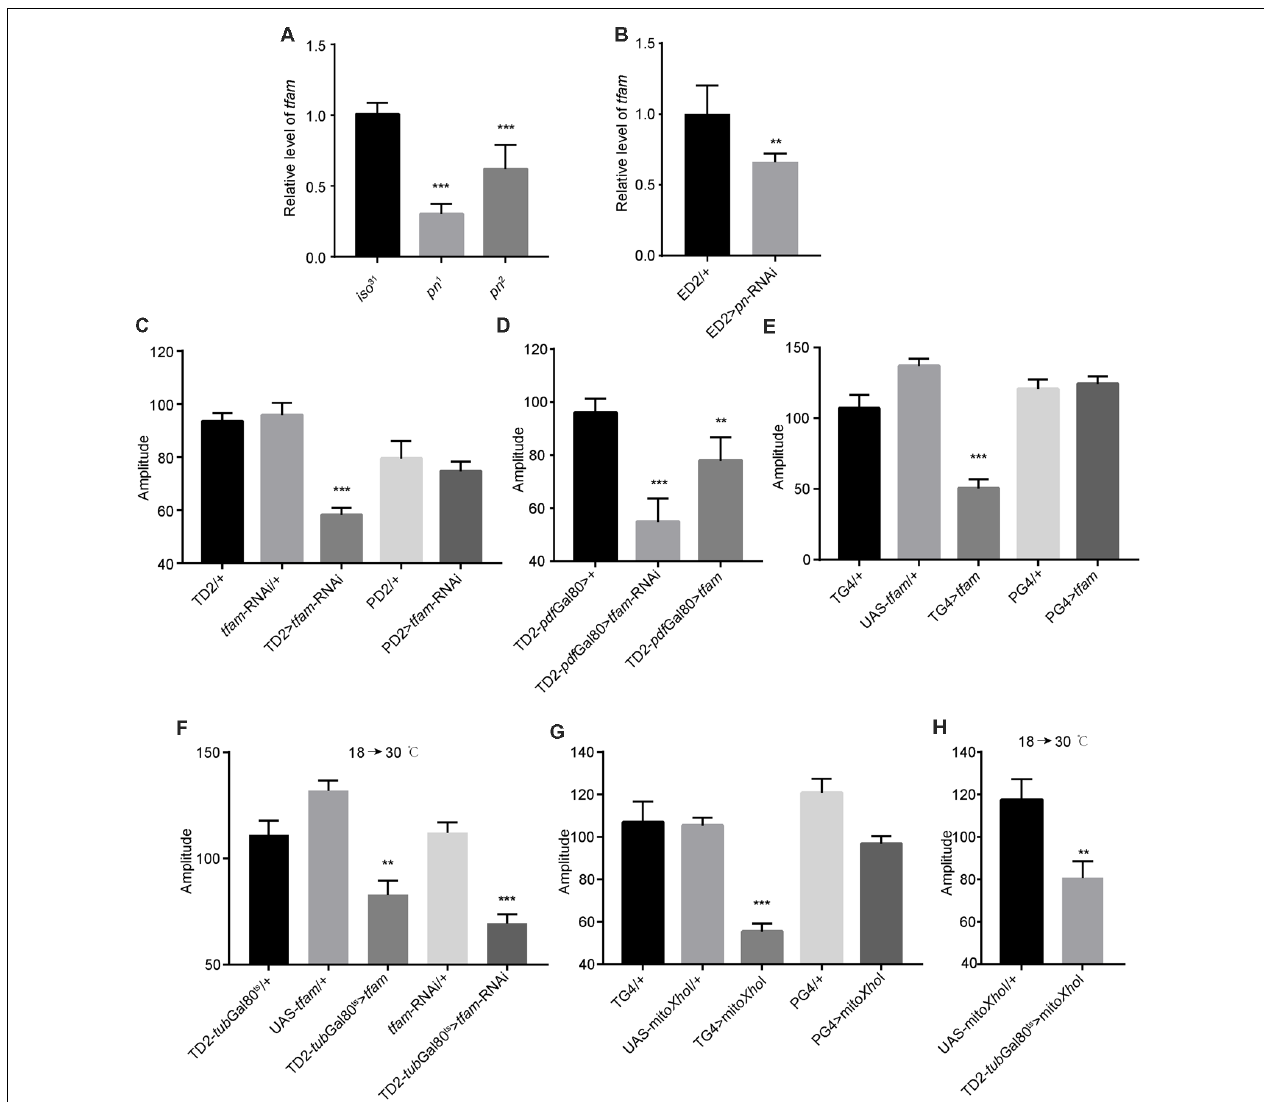
FIGURE 5 | Mitochondrial dysfunction decreases the robustness of circadian rhythm. (A) tfam mRNA levels in the heads of pn mutants and controls. (B) tfam mRNA levels in the heads of flies in which pn is silenced with a pan-neuronal driver and control flies. ED2 indicates elav -Gal4; UAS- Dicer2 . (C) Amplitudes of circadian rhythms in flies in which tfam has been silenced in the circadian neurons with TD2 or PD2 drivers. (D) Amplitudes of circadian rhythms in flies in which tfam has been silenced or overexpressed in PDF-negative circadian tissues. (E) Amplitudes of circadian rhythms in flies in which tfam has been overexpressed in circadian neurons with tim -Gal4 or pdf -Gal4 drivers. (F) Amplitudes of circadian rhythms in flies in which tfam was silenced or overexpressed in adulthood stage with tim -Gal4 driver. Flies were crossed and reared under 18 ◦ C and monitored behavior under 30 ◦ C. (G) Amplitudes of circadian rhythms in flies in which mitoXhoI has been overexpressed in circadian neurons with tim -Gal4 or pdf -Gal4 drivers. (H) Amplitudes of circadian rhythms in flies in which mitoXhoI was overexpressed in adulthood stage with tim -Gal4 driver. Flies were crossed and reared under 18 ◦ C and monitored behavior under 30 ◦ C. The amplitudes are shown as means ± SEM ( n = 30–45). At least two independent repeats were performed. ∗∗ P < 0.01, ∗∗∗ P <